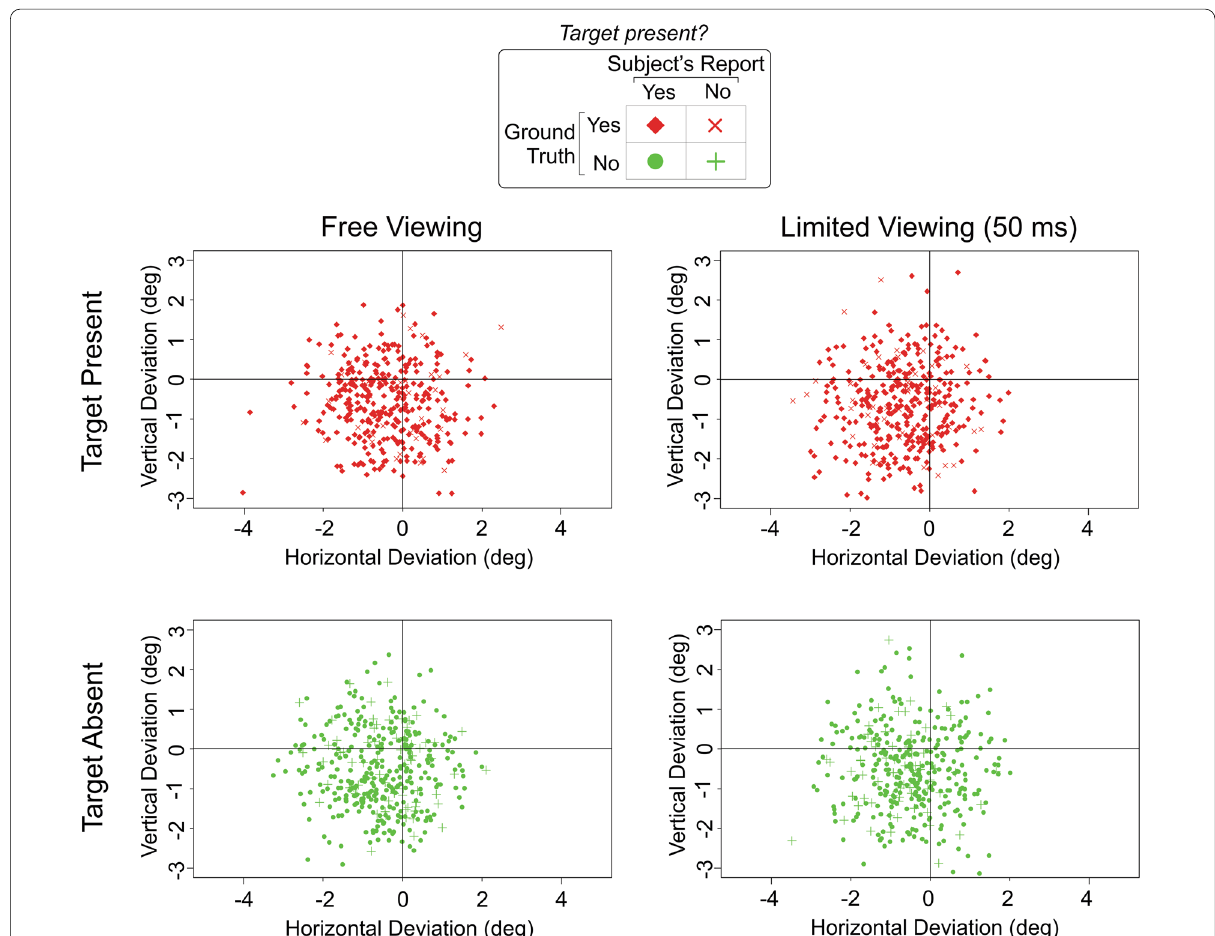
Fig. 4 Localization of camouflage targets in Experiment 2. Plotting conventions are the same as in Fig. 2. See text and legend to Fig. 2 for